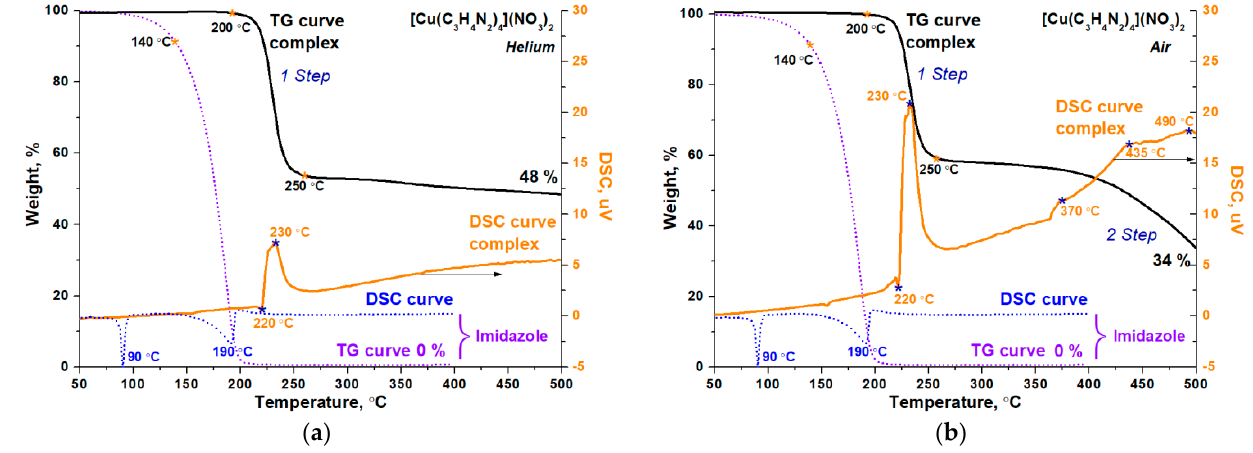
Figure 3. Thermal analysis data for [Cu(C 3 H 4 N 2 ) 4 ](NO 3 ) 2 complex prepared by melting-assisted solvent-free synthesis. Heating rite is 5 ° С /min in ( a ) helium and ( b ) air.